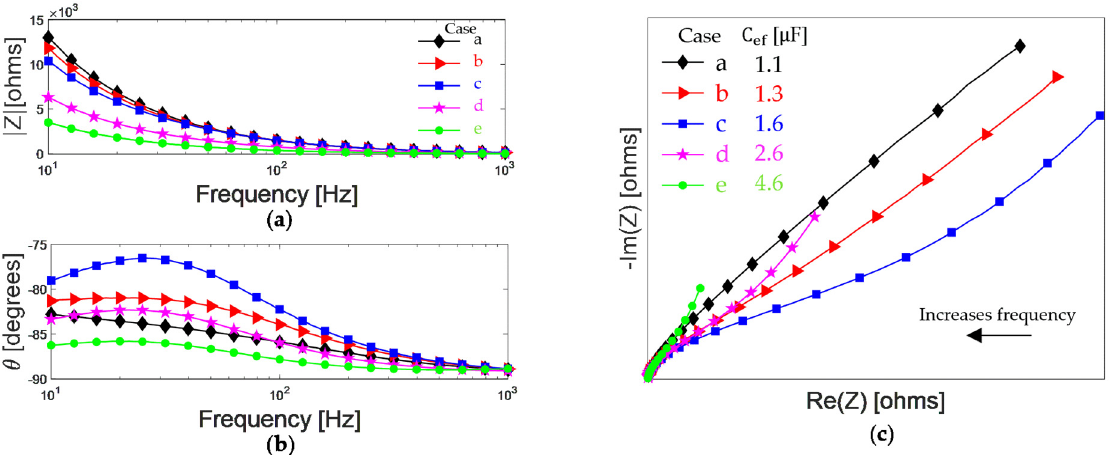
Figure 3. Impedance magnitude ( a ), phase angle ( b ), and Nyquist plot ( c ) of the proposed electrical circuit for cases depicted in Table 1.